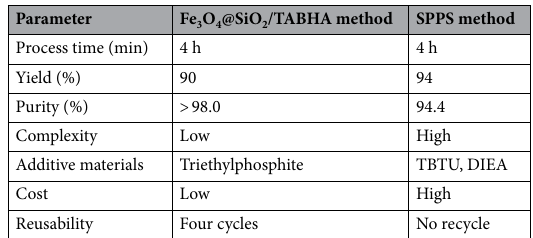
Table 3. Comparative information of Fmoc-l-Ala-l-Ala-COOMe dipeptide synthesis by the designed Fe 3 O 4 @ SiO 2 /TABHA catalytic system, and solid-phase peptide synthesis method.